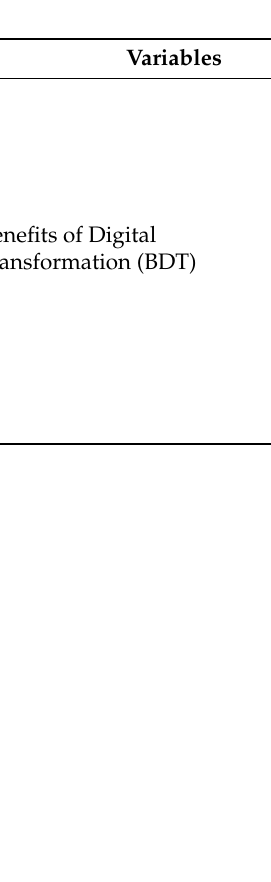
Figure A1. Heterotrait–Monotrait Ratio (HTMT).